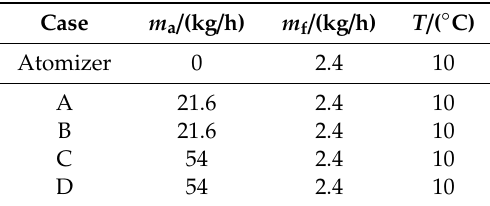
Figure 5. ( a ) Schematic of cone angle and ( b ) cone angles of different air-blast atomizer structures. Table 1. Experiment conditions.